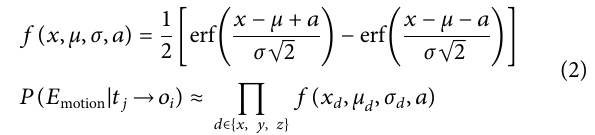
Frontiers in Computer Science |